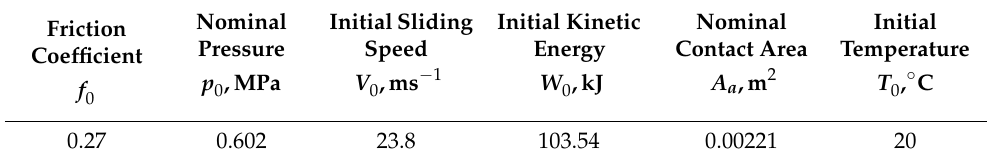
Table 2. Input parameters [14].